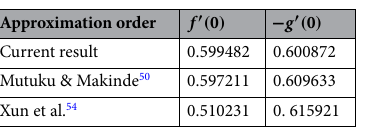
Table 1. Comparative assessment of current outcomes with the published